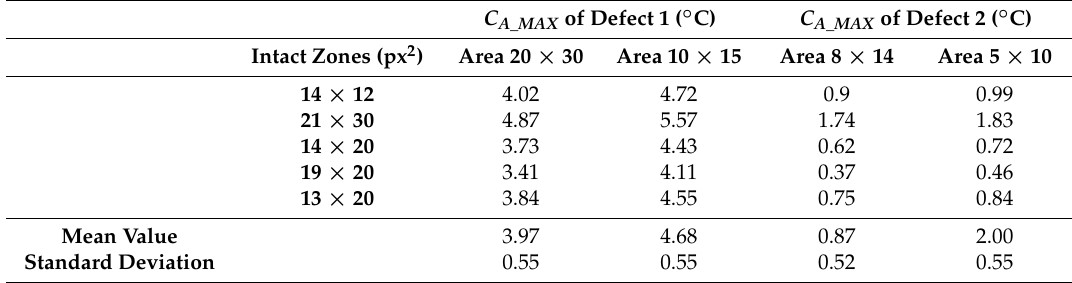
Table 6. Maximum absolute contrast value for rectangular computation shape